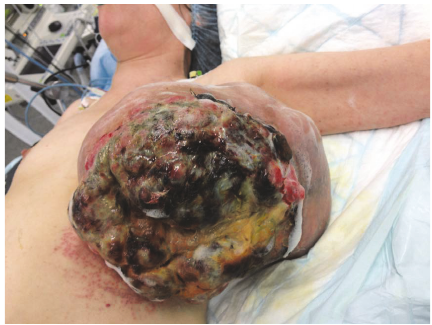
Figure 1: Picture of the left breast mass at diagnosis.